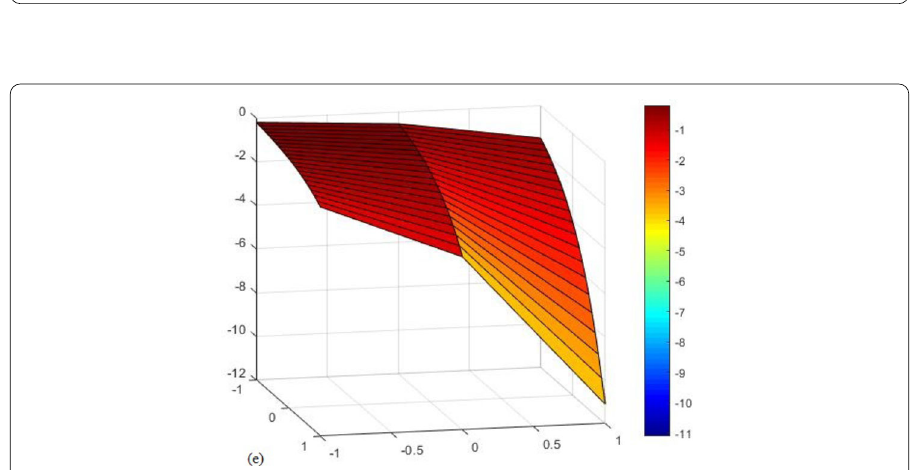
Figure 9 The graph of approximate ( e ) solution of (cid:11) ( χ , ϕ , η ) at ϒ = 0.4 of Example 2